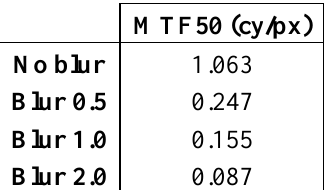
Table 8. Values of MTF50 for the spectra shown in Figure